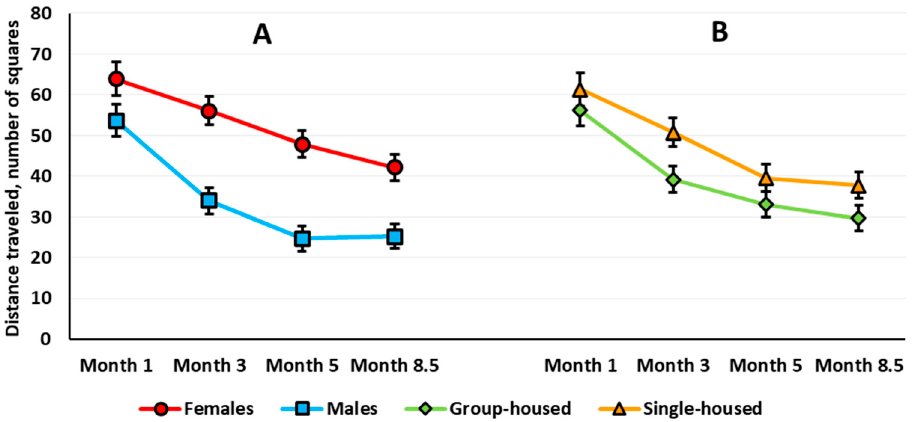
Figure 5. The total distance traveled (number of squares) for 3 min in rats in the classic open field test: ( A ) sex and ( B ) housing factors. See supplementary materials, Table S4, Figure S2, Table